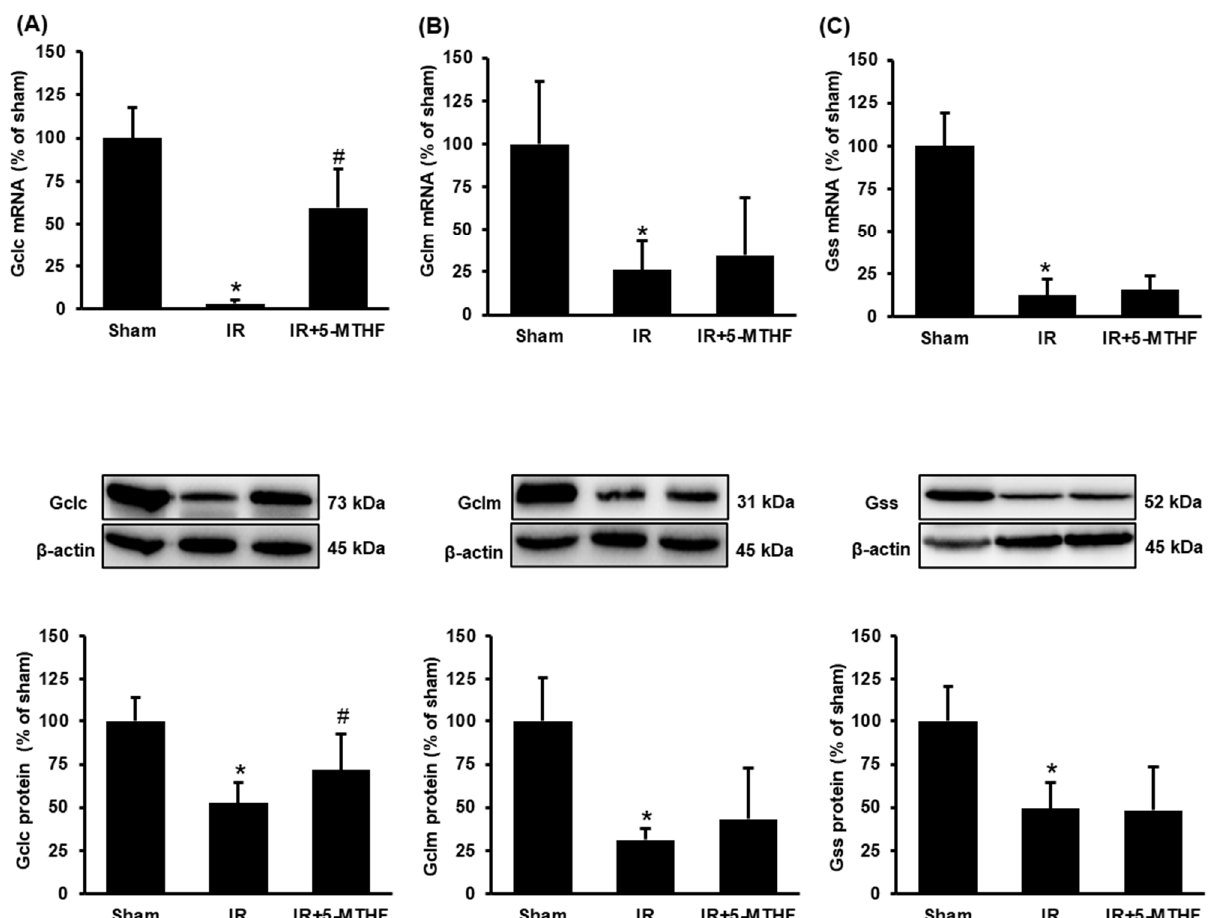
Figure 3. Glutathione-synthesizing enzyme expression in the kidney. Rats were subjected to sham operation (Sham), kidney ischemia-reperfusion (IR) or ischemia-reperfusion with 5-MTHF injection (IR + 5-MTHF). The mRNA and protein expression of ( A ) glutamate-cysteine ligase catalytic subunit (Gclc), ( B ) glutamate-cysteine ligase modifier subunit (Gclm) and ( C ) glutathione synthetase (Gss) were measured. Results are expressed as mean ± SD ( n = 5–8). * p < 0.05 when compared with the value obtained from the Sham group. # p < 0.05 when compared with the value obtained from the IR group.